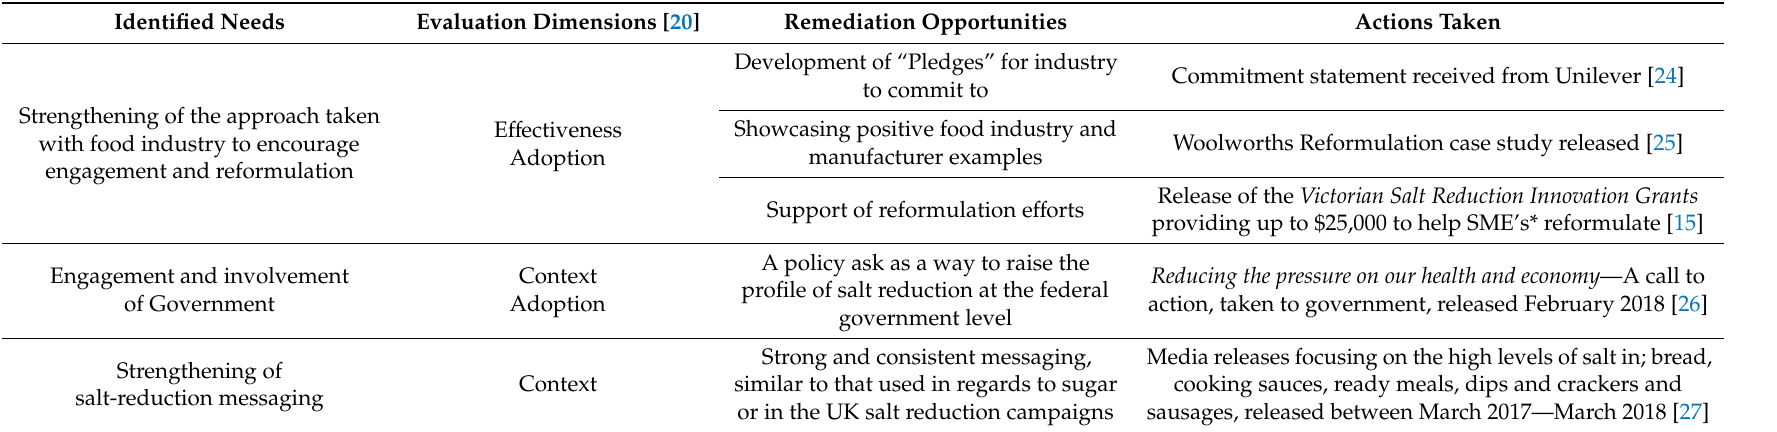
Table 2. Identified needs, remediation opportunities and actions taken for the Victorian Salt Reduction